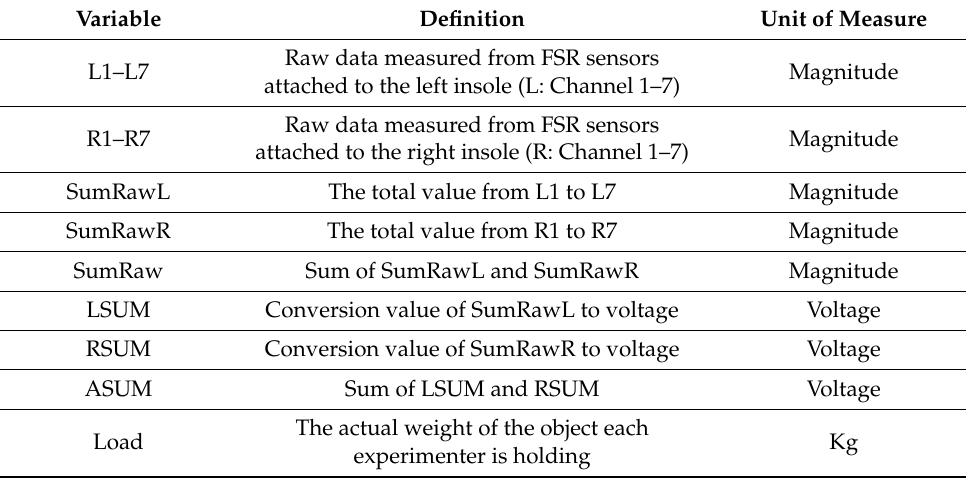
Table 3. Definition of variables included in one data